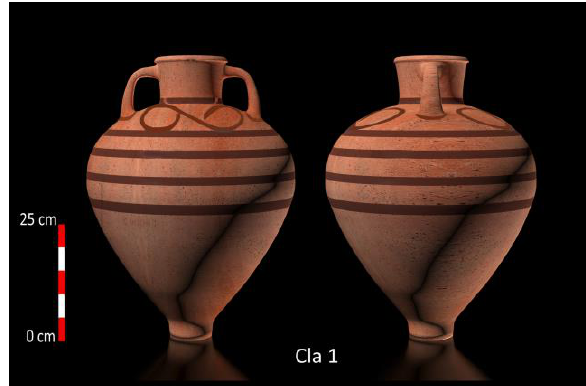
Figure 4. 3D model of a Clazomenian amphoras from 650 BC.